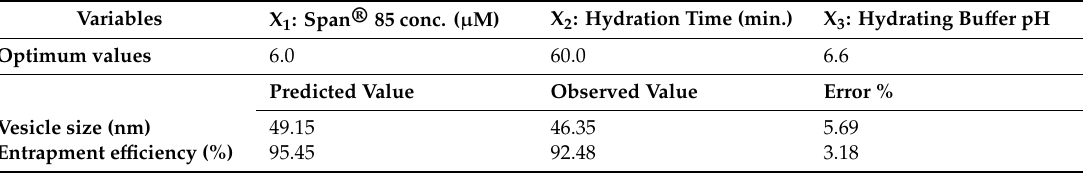
Table 4. Optimized variables levels of the optimized FLB niosomes and its predicted and observed responses.